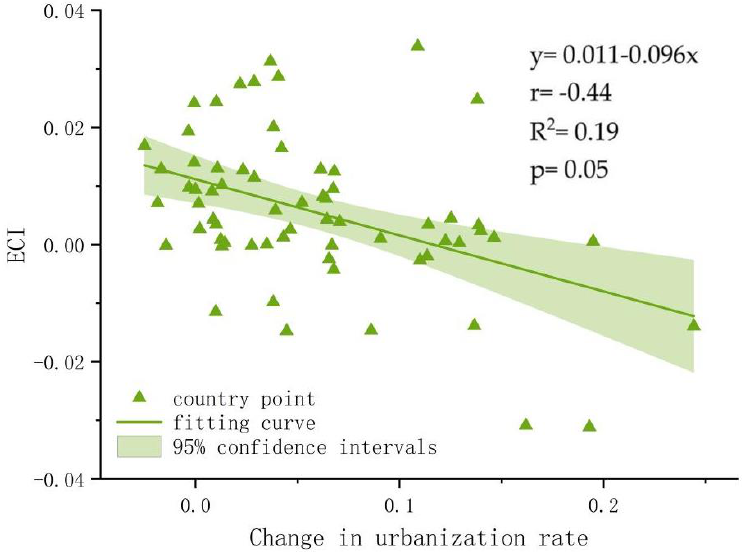
Figure 9. Correlation between ECI and urbanization rate changes.